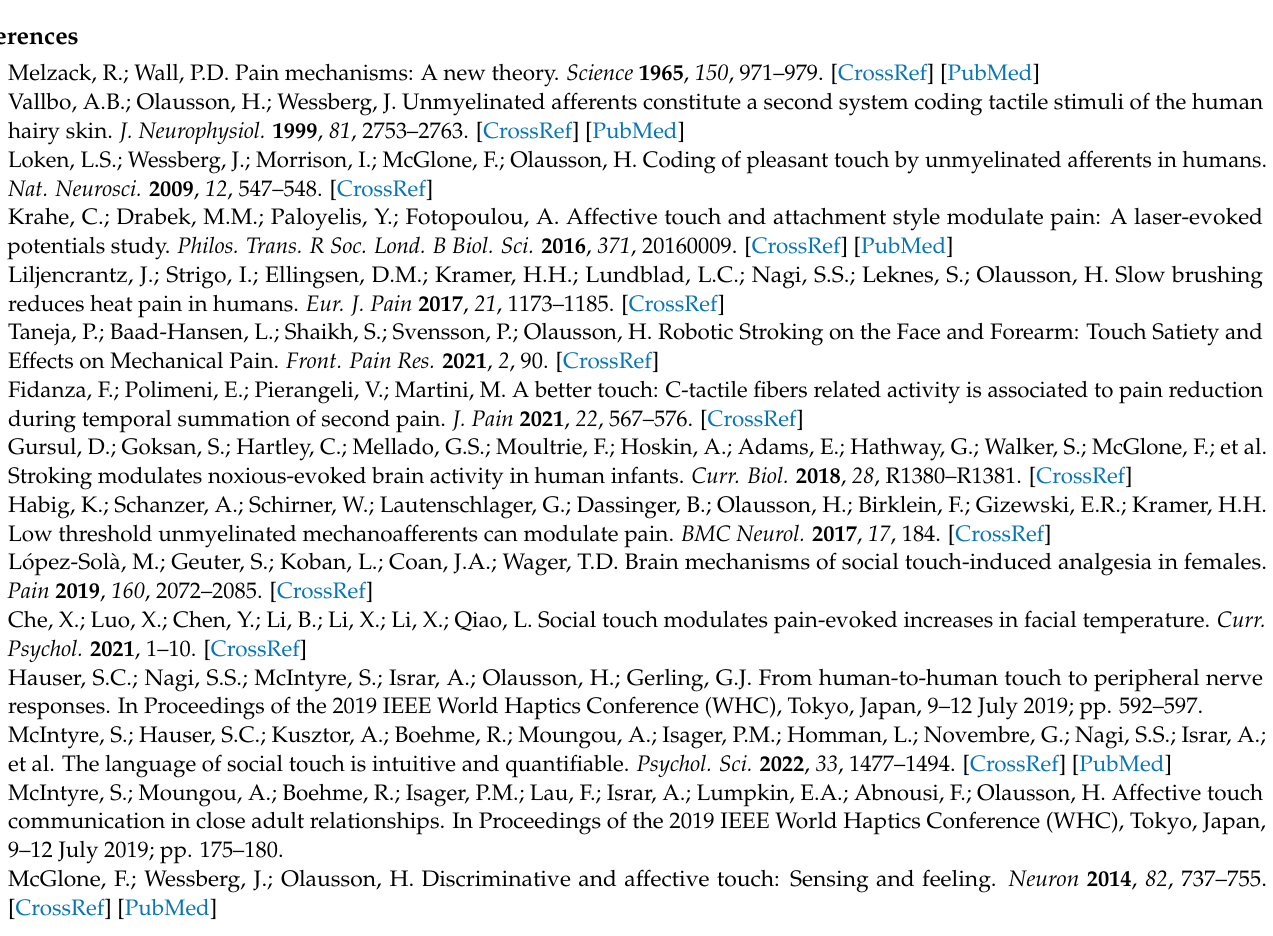
Figure S1: The MR-safe part of the pressure device. The hand is placed in the upper section and an inflatable pillow, connected to an air pump, is placed in the lower section, to move the peg up for mechanical pressure